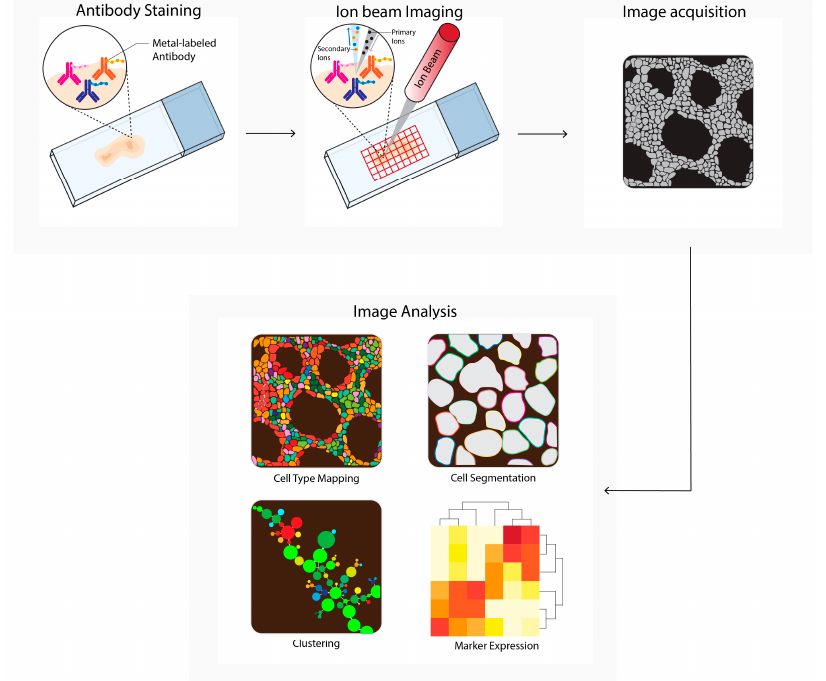
Figure 4. Multiplexed ion beam imaging by time-of-flight (MIBI-TOF) workflow. Tissues are first labeled with a multiplex panel of antibodies conjugated with heavy metals containing polymers. Next, these are directly ionized to generate secondary ions. Ions are filtered and detected by time-of flight mass spectrometry. Next, multiplex images are generated, containing images depicting expressions for each separate antibody–metal conjugate. These images can be processed into single-cell expression data. During imaging analysis, these images can be processed into single-cell expression data and downstream analysis is performed (e.g., cell type mapping, clustering, marker